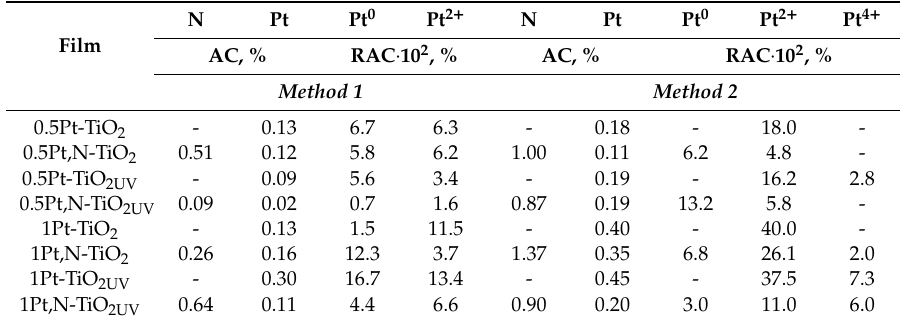
Table 6. Atomic contents (ACs) of N and Pt obtained from XPS data and recalculated relative atomic contents (RACs) of Pt species.